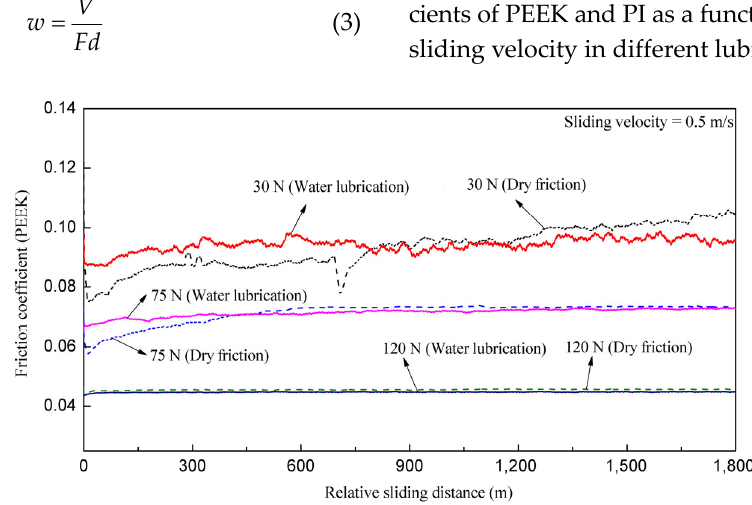
Fig. 3 Friction coefficient of PEEK as a function of relative sliding distance for different